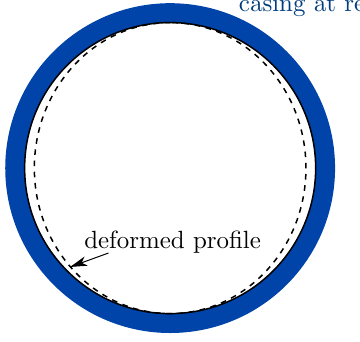
Figure 1. 2-lobe casing